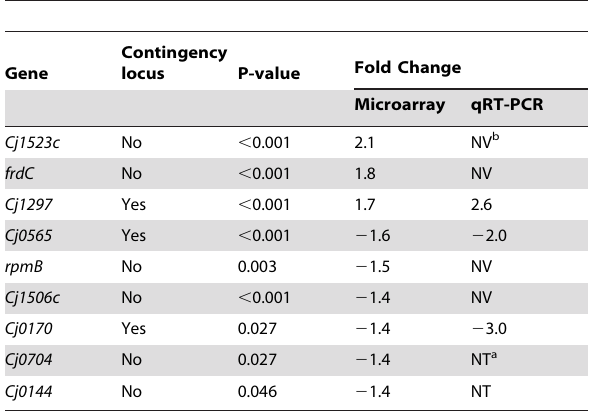
Table 3. Genes differentially expressed in the mouse-adapted variant during in vivo